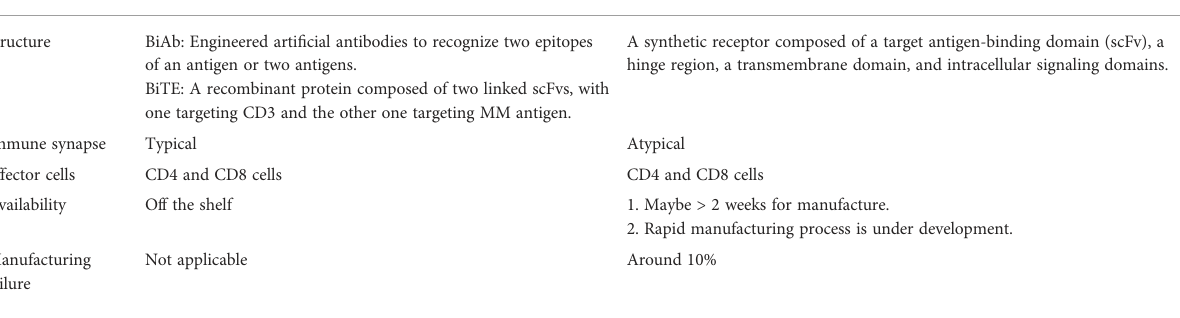
TABLE 2 T-cell-redirecting BiAb/BiTE vs CAR-T cell therapy in MM.